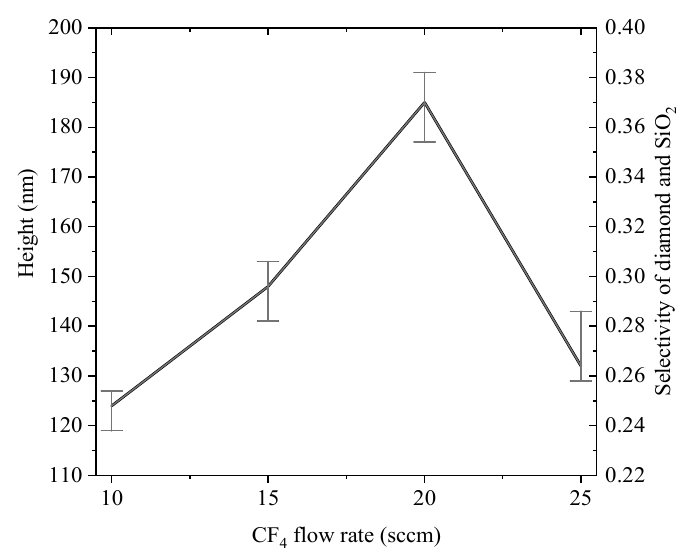
Figure 6. Relationship between submicron lens height and CF 4 flow rate (left axes), and selectivity of diamond and SiO 2 as a function of CF 4 flow rate (right axes).